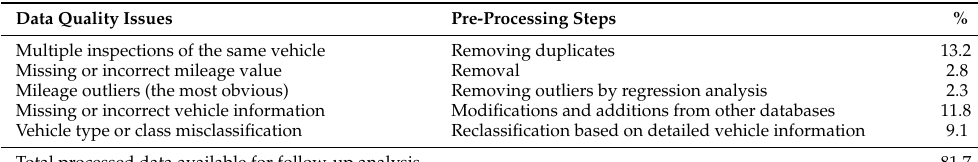
Table 2. Data quality checks and pre-processing